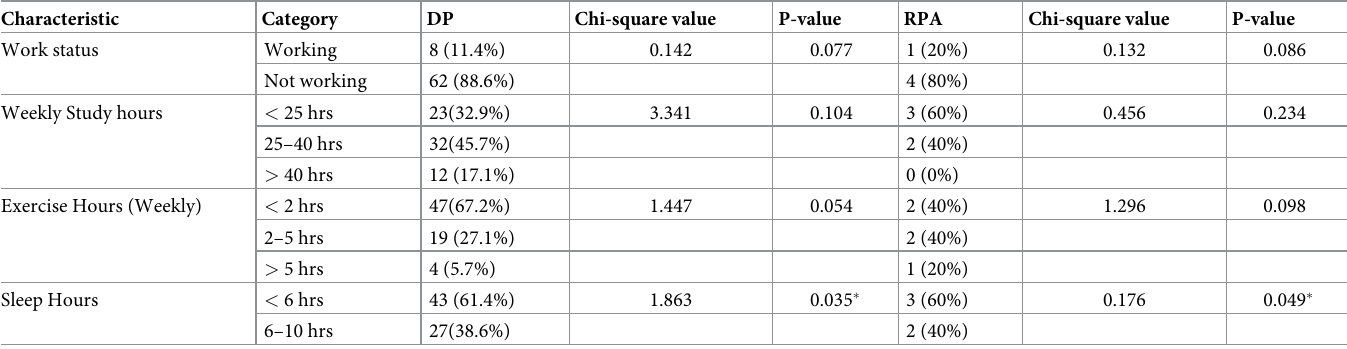
Table 7. Results on practices and burnout levels.